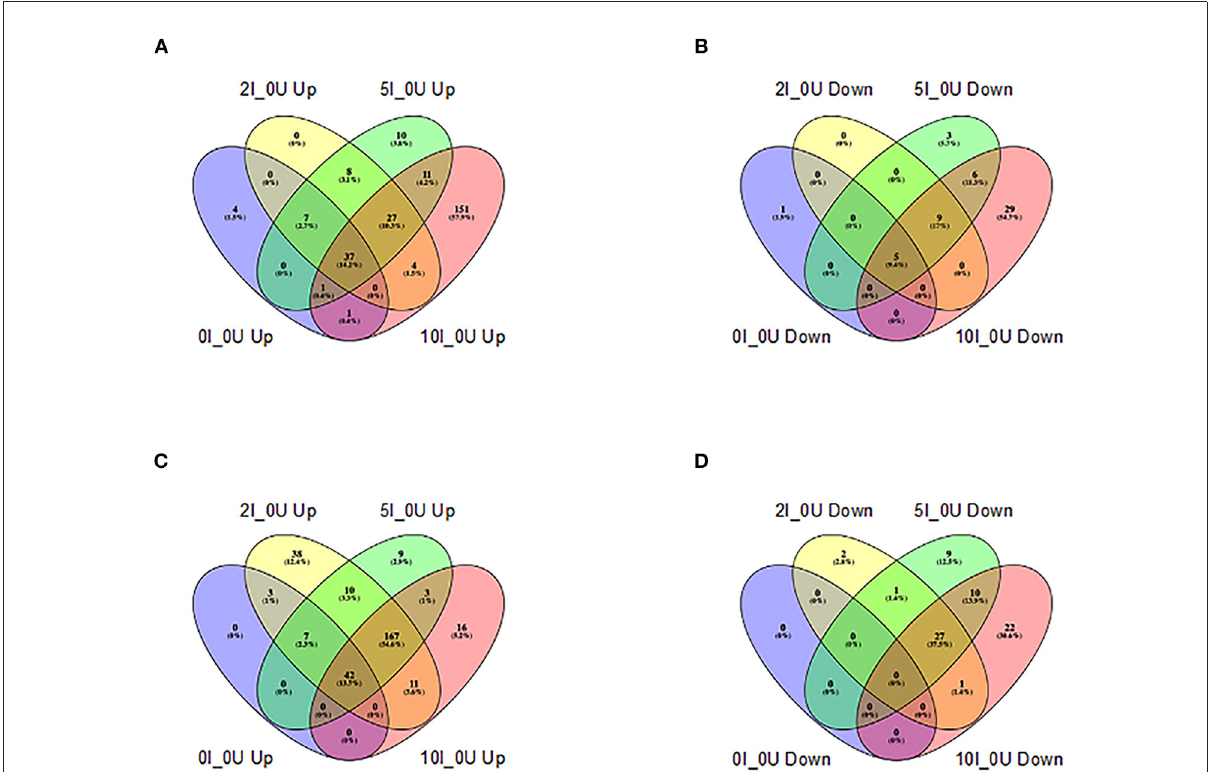
FIGURE8 Venn analysis of shared REACTOME pathways of differentially expressed genes in cecum and distal colon of Cr -infected mice. Differentially expressed REACTOME pathways (up-or downregulated) > 1.5 fold at a FDR adjusted p < 0.05) identified by DAVID analysis (https://david.ncifcrf. gov) in each tissue in animals fed 10% RPS, were analyzed by Venn analysis using the online tool Venny2.1 (https://bioinfogp.cnb.csic.es/tools/ venny/). Genes that were upregulated (A) or downregulated (B) in cecum or upregulated (C) or downregulated (D) in DC are shown. n =